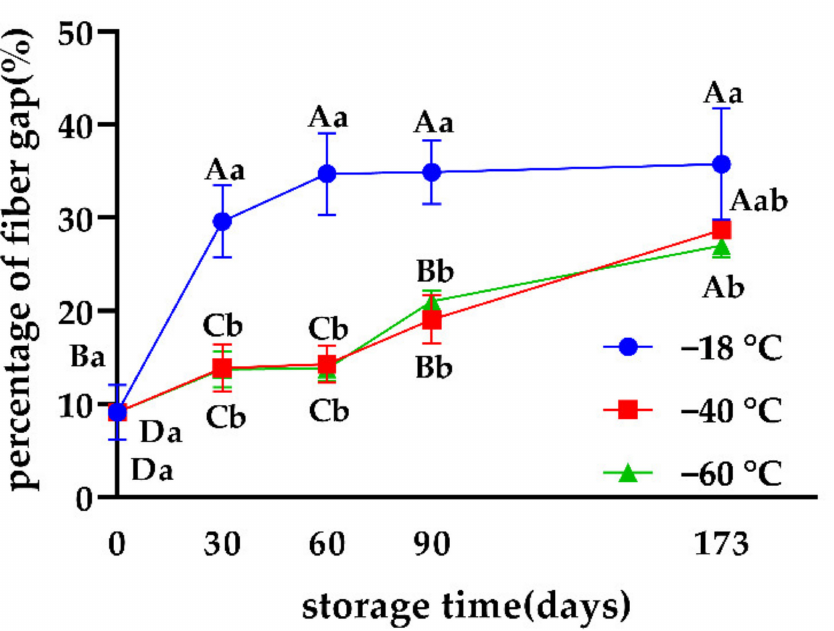
Figure 2. Effects of different freezing storage temperatures on fiber gap percentages of snowflake beef ( n = 4); ab represents significant differences of different freezing temperatures for the same storage time; ABCD represents significant differences of different freezing times for the same storage